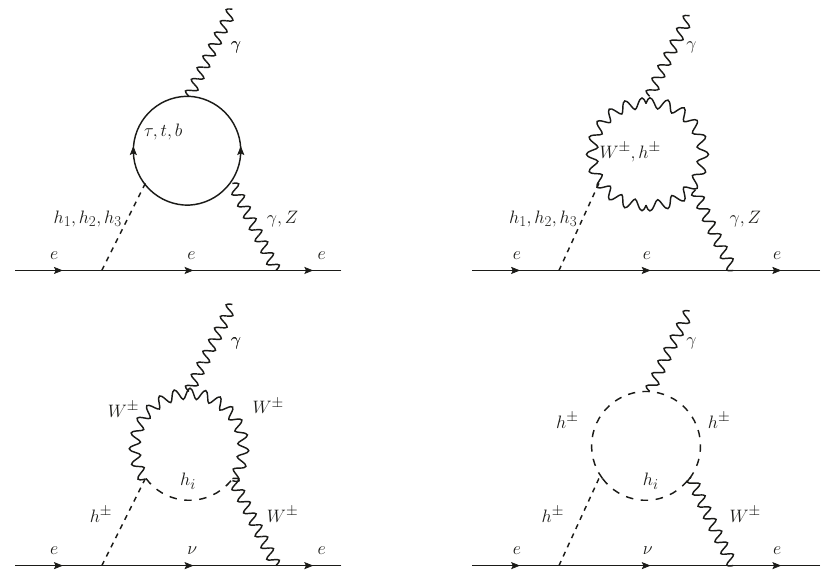
Figure 1 . Representative 2-loop Barr-Zee diagrams which generate EDM due to CP violation. Similar diagrams contribute dominantly in muon anomalous magnetic moment when electron is replaced by